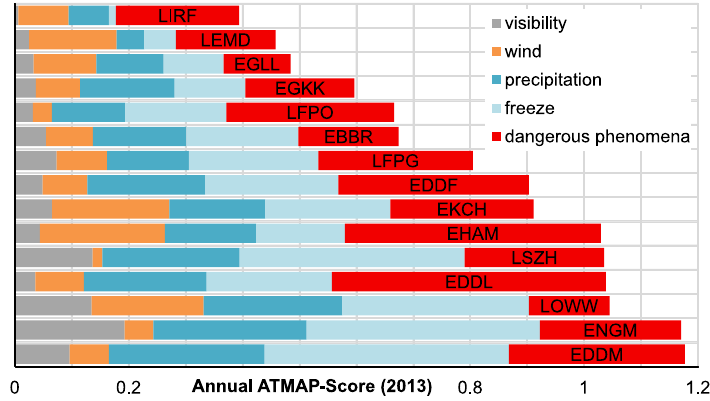
Figure 2. Ratio of different weather classes at selected European airports (top down: Rom-Fiumicino, Madrid, London-Heathrow, London-Gatwick, Paris-Orly, Brussels, Paris-Charles-de-Gaule, Frankfurt, Copenhagen, Amsterdam, Zurich, Dusseldorf, Vienna, Oslo,